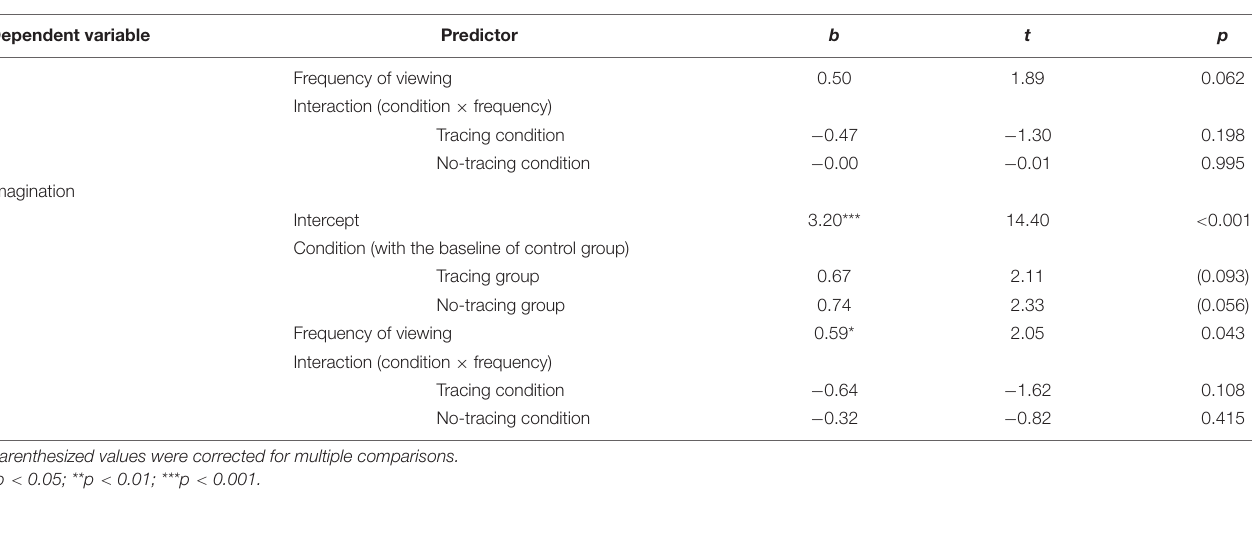
Frontiers in Human Neuroscience |